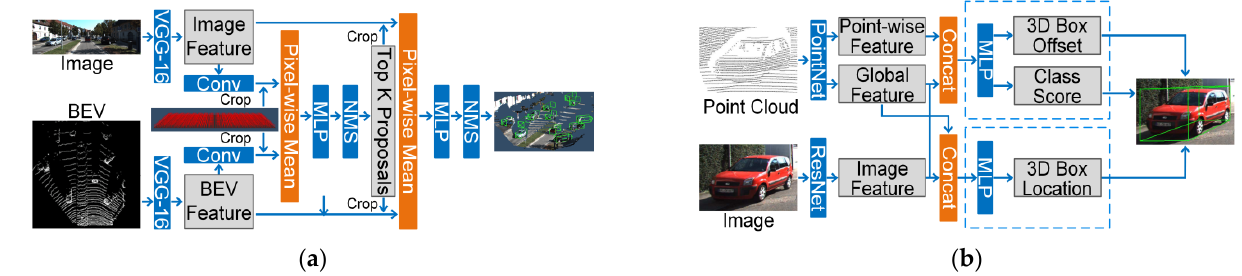
Figure 8. The representative detection methods using multi-stage feature-based fusion strategy. ( a ) AVOD; ( b ) PointFu- sion.